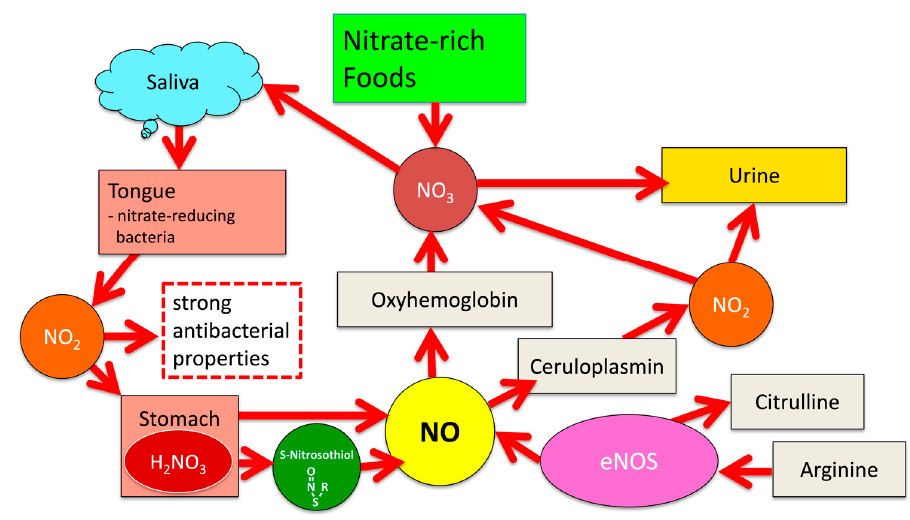
Figure 1. Pathways of the NO-NO 2 -NO 3 cycle.